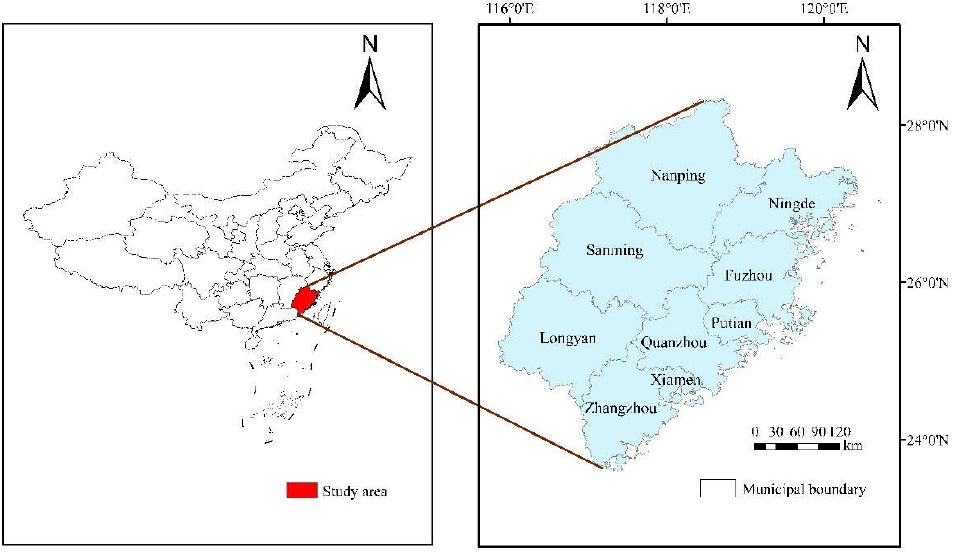
Figure 1. Location of study area.